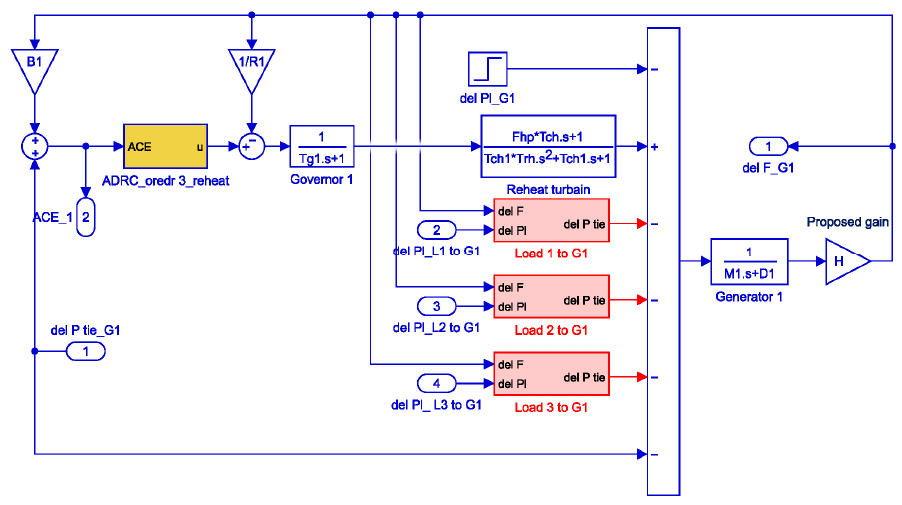
Figure 12. Proposed dynamic model of power plant 1.